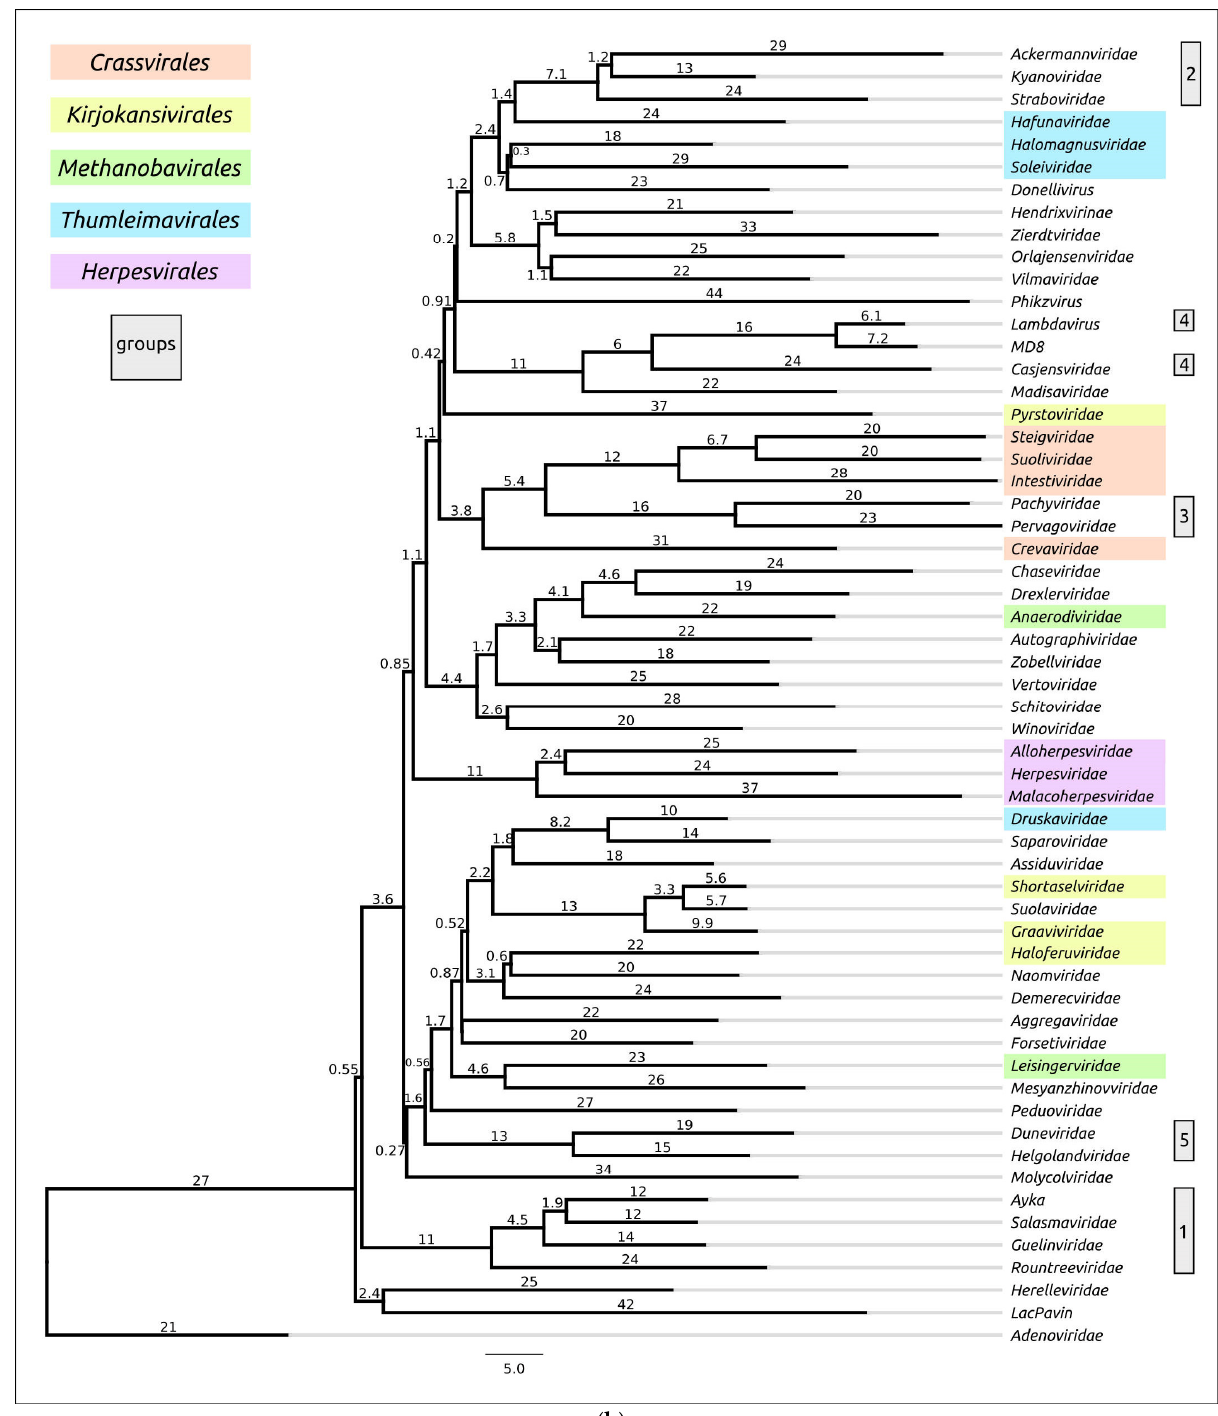
Figure 9. Matrix ( a ) and dendrogram ( b ) based on the pairwise Z-score comparisons with DALI, using 57 ATPase domain structures extracted from TerL AF models including an Adenoviridae terminase. The branch lengths are measured using the DALI Z-score and the tree was rooted to Adenoviridae .